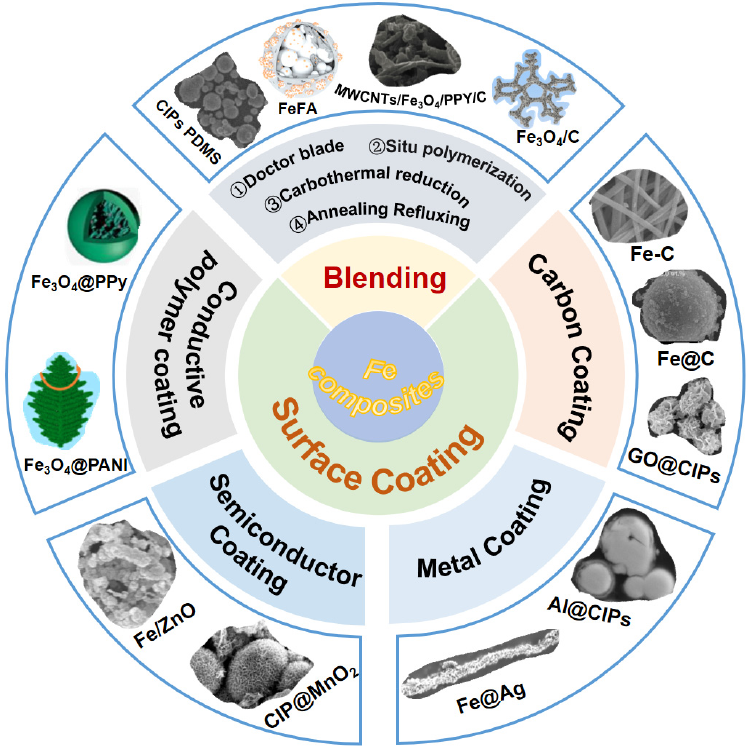
Figure 7. Classification and preparation of partially recent representative Fe-based composites.